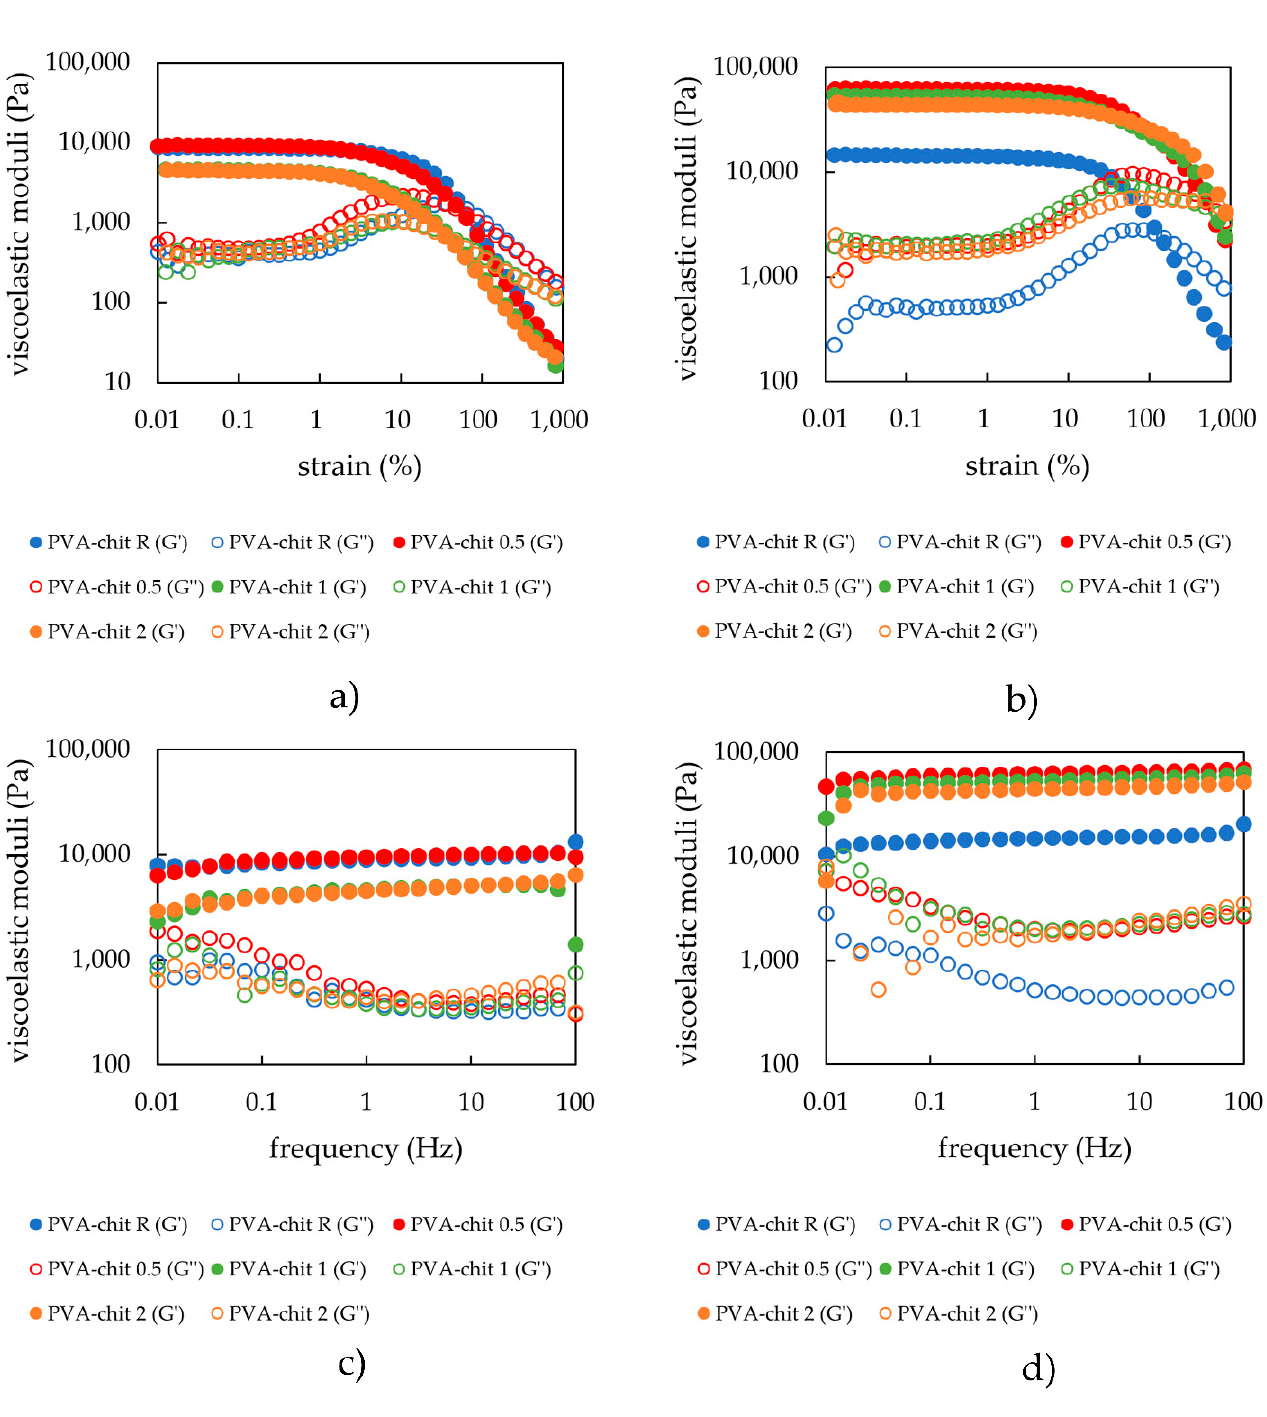
Figure 7. ( a ) Strain sweep of PVA-chitosan hydrogels with the different lecithin concentrations (0, 0.5, 1, and 2 wt.%) after preparation; ( b ) strain sweep of PVA-chitosan hydrogels with different lecithin concentrations (0, 0.5, 1, and 2 wt.%) after drying and rehydration of the xerogels (frequency applied–1 Hz); ( c ) frequency sweep of PVA-chitosan hydrogels with different lecithin concentrations (0, 0.5, 1, and 2 wt.%) after preparation; ( d ) frequency sweep of PVA-chitosan hydrogels with different lecithin concentrations (0, 0.5, 1, and 2 wt.%) after drying and rehydration of the xerogels.